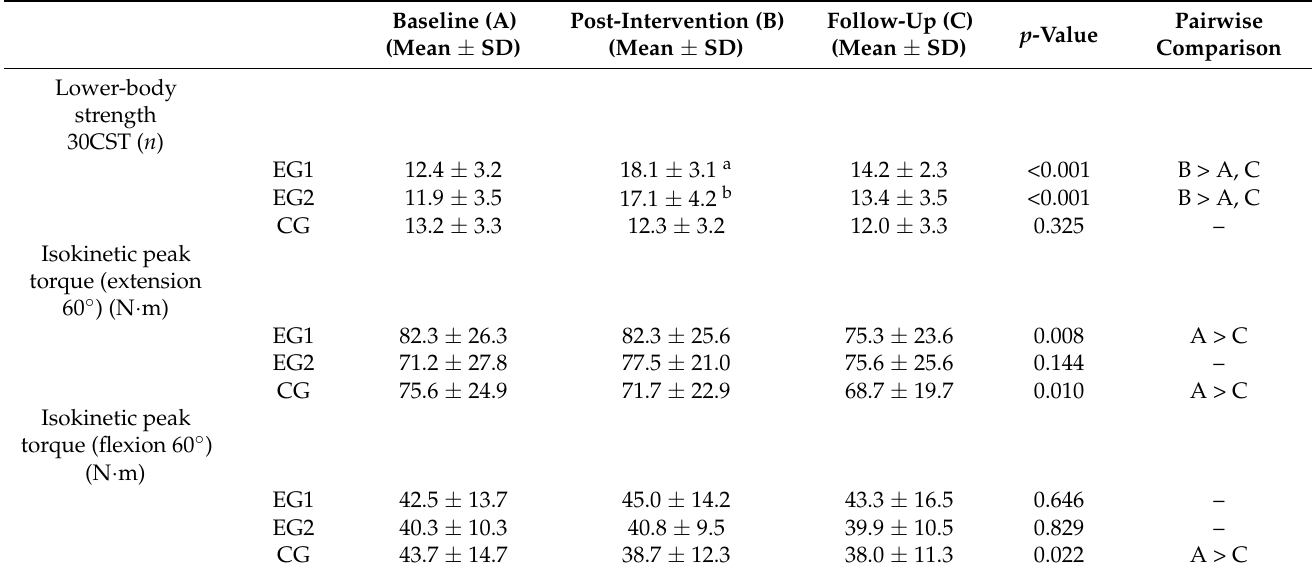
Table 3. Impact of the interactive cognitive–motor programs on physical function variables.